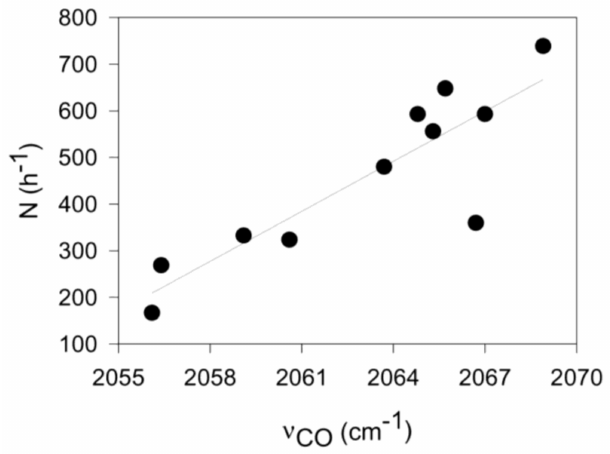
Figure 2. Plot of N (moles of 1,3-butadiene polymerized per mol of vanadium per hour) vs. the phosphine donor ability [as measured by the electronic parameter v CO based on the carbonyl stretching frequencies in Ni(CO) 3 L complexes (L = phosphine ligand)] as defined by Tolman